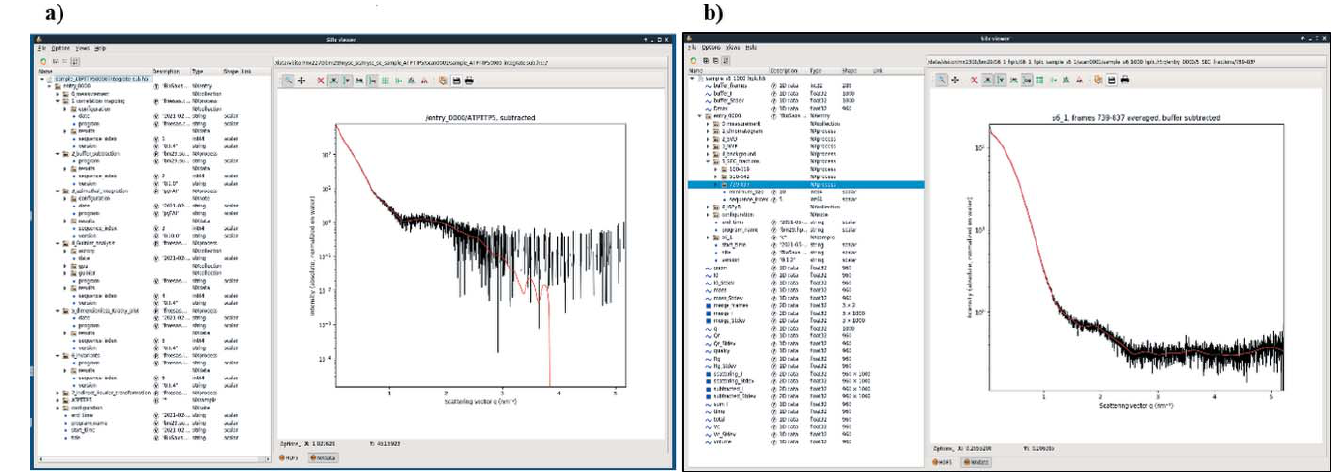
Figure 7 Data analysis results visualized by silx view. Subtracted curve in ( a ) sample changer and ( b ) SEC-SAXS modes.